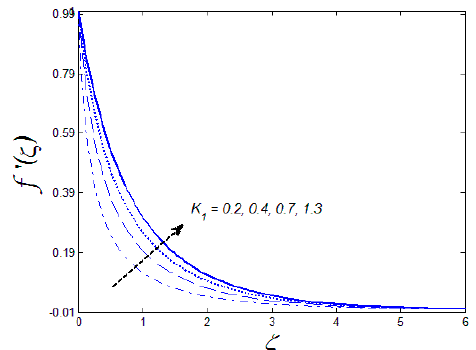
Figure 4. Upshot of K 1 on velocity profile f ′ ( ζ ) .